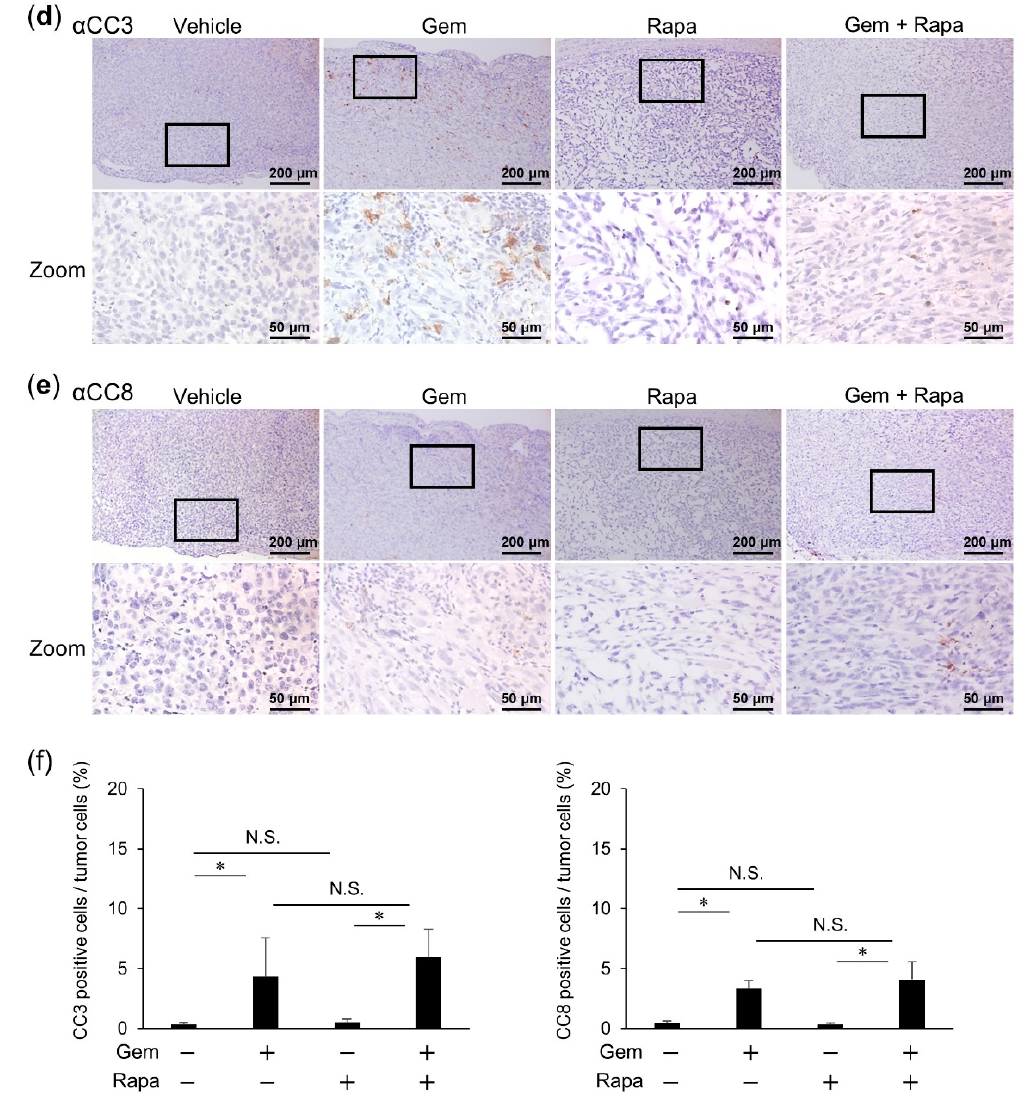
Figure 6. Combined administration of Gem and Rapa reduced the Ki-67 labeling index. Primary tumors were resected at day 35 after transplantation of 143B cells. ( a – c ) Hematoxylin–eosin (H&E) staining and immunohistochemical staining were performed using primary antibodies against Ki-67, and Ki-67-positive cells were counted and determine the Ki67 labeling index. ( d – f ) Immunohistochemical staining was performed to measure the levels of cleaved caspase-3 ( α CC3) and cleaved caspase-8 ( α CC8), followed by quantification. Bar = 200 μ m in the upper panels. Bar = 50 μ m in the lower panels. Data are shown as the mean ± SD ( n = 5). * p < 0.05. N.S., not significant.